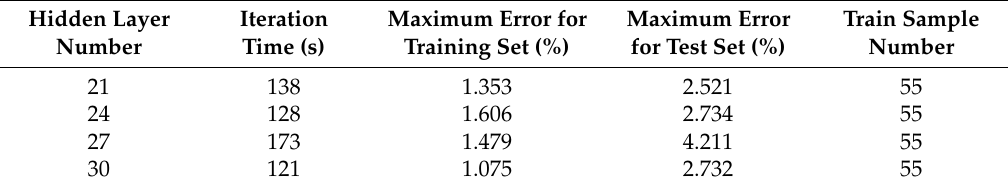
Table 2. Performance of the BP network in different hidden